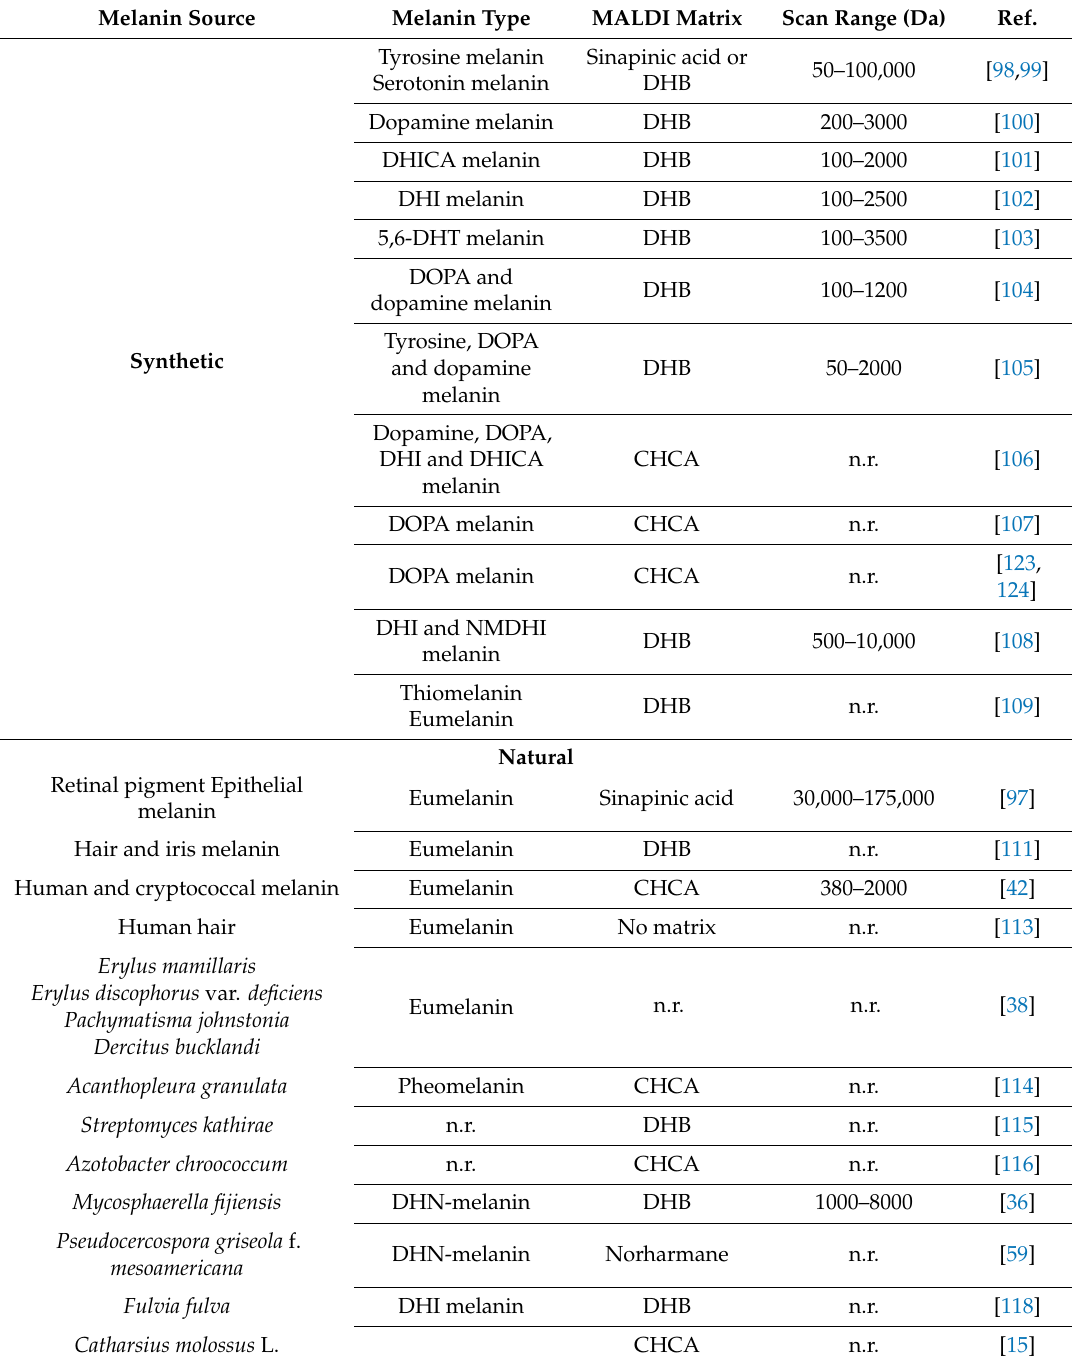
Table 9. Synthetic and natural melanins analysis using